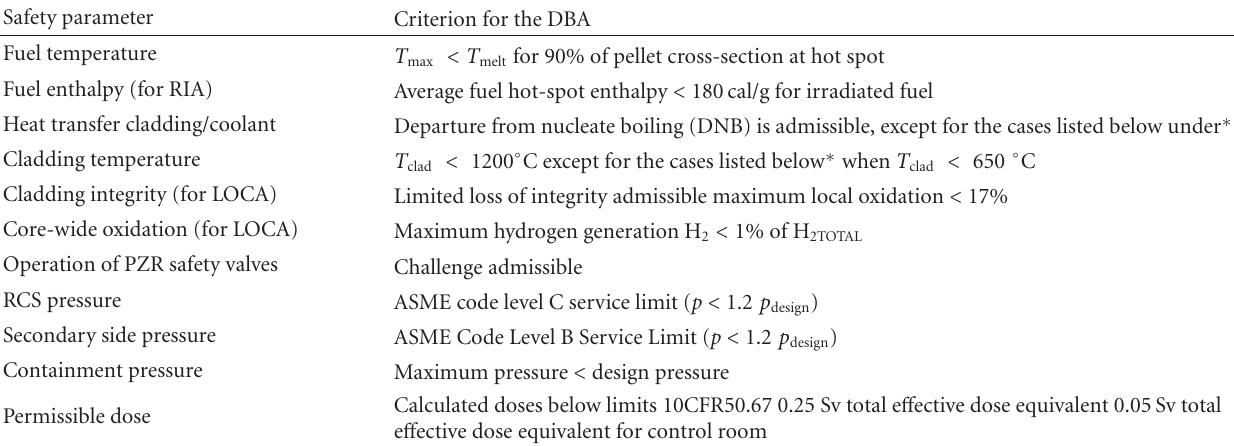
Table 1: Specific acceptance criteria for design basis accidents